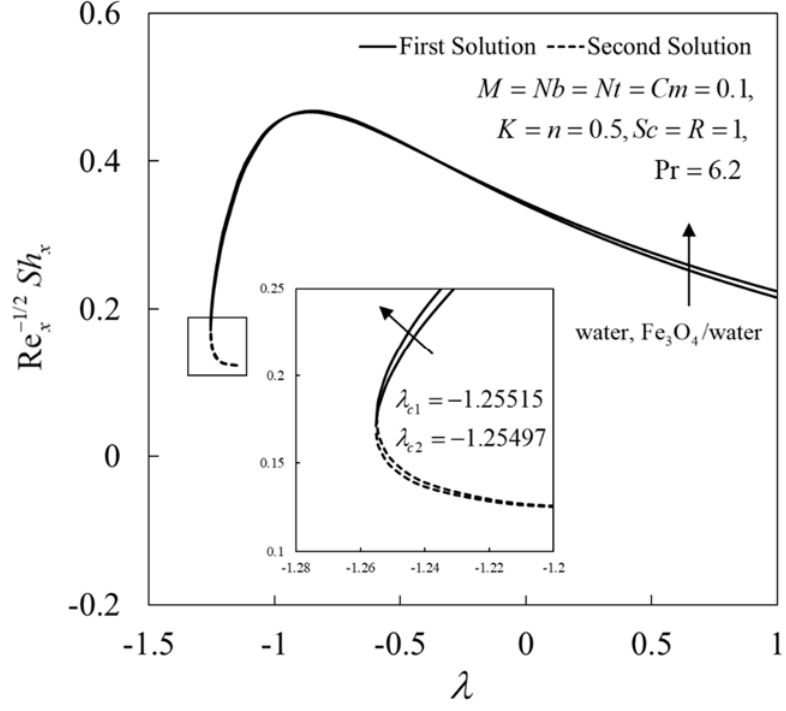
Figure 7. Re (cid:3051)(cid:2879)(cid:2869)/(cid:2870) 𝑆ℎ (cid:3051) vs.𝜆 for water and Fe 3 O 4 /water. The influences of 𝐾 on the velocity 𝑓′(cid:4666)𝜂(cid:4667) , the microrotation 𝑔(cid:4666)𝜂(cid:4667) , the temperature 𝜃(cid:4666)𝜂(cid:4667) , and the concentration 𝜒(cid:4666)𝜂(cid:4667) profiles when 𝜆 (cid:3404) (cid:3398)1.2, 𝑛 (cid:3404) 0.5, 𝑀 (cid:3404) 𝑁𝑏 (cid:3404) 𝑁𝑡 (cid:3404) 𝐶𝑚 (cid:3404) 0.1, Sc (cid:3404) 𝑅 (cid:3404) 1, Pr (cid:3404) 6.2, and 𝜑 (cid:3404) 0.02 are presented in Figures 8–11. Dual solutions exist that can be seen from these profiles, where both satisfy the infinity boundary conditions (14) asymptotically. Figures 8 and 9 show that the velocity 𝑓′(cid:4666)𝜂(cid:4667) and the microrotation